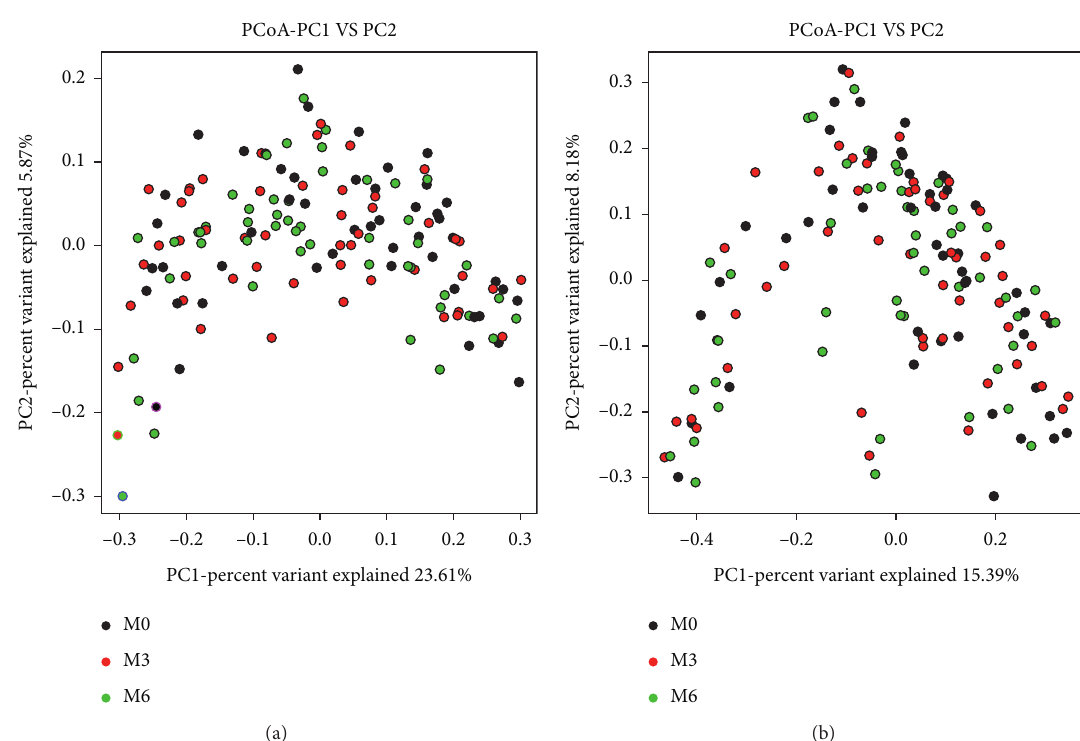
Figure 1: Principal component analysis plot based on Bray-Curtis distance (a) and unweighted UniFrac distances (b) for fecal microbiota. M0, baseline; M3, at three months after inulin intervention; M6, at six months after inulin